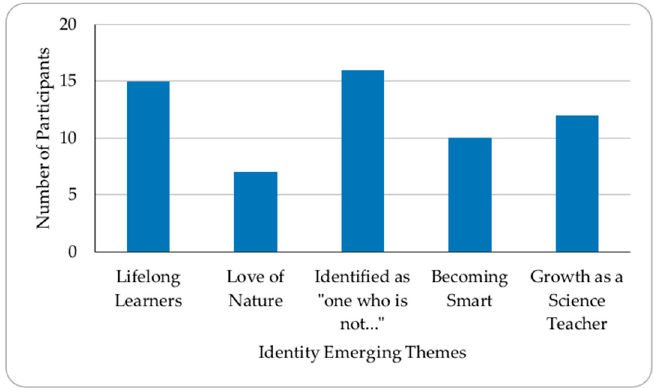
Figure 4. The frequency of emerging themes for the code identity.